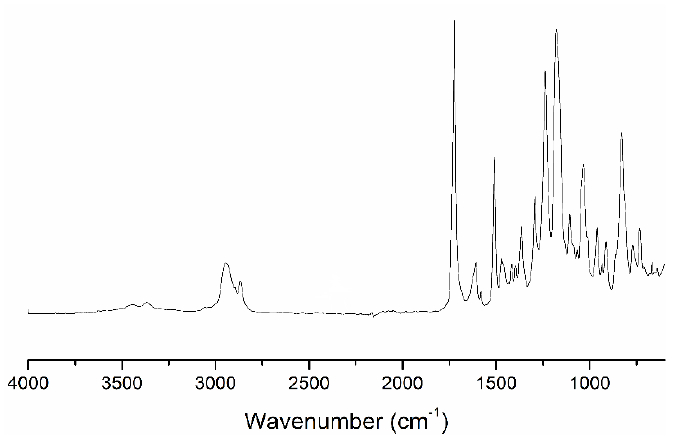
Figure 1. Infrared spectrum of the sample 5050DDM before curing.